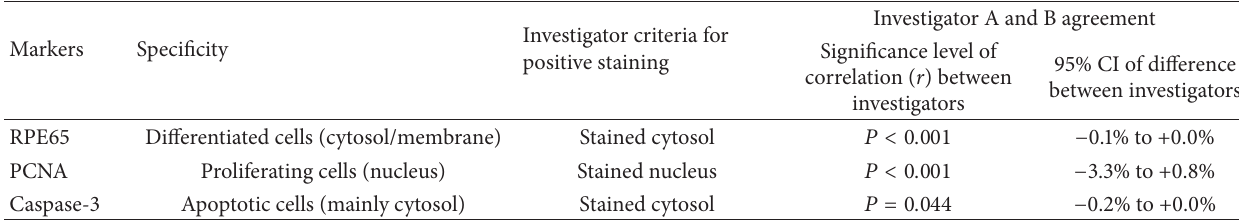
Table 1: Characterization of retinal pigment epithelial cells.